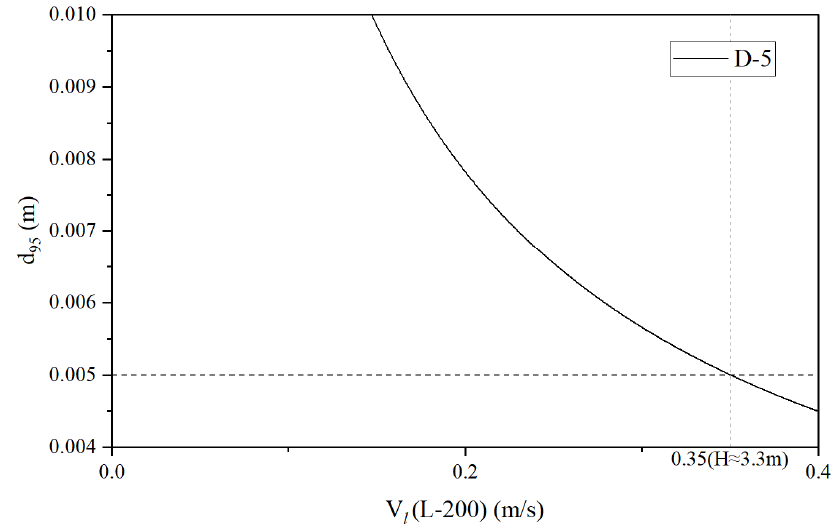
Figure 2. Bubble 𝑑